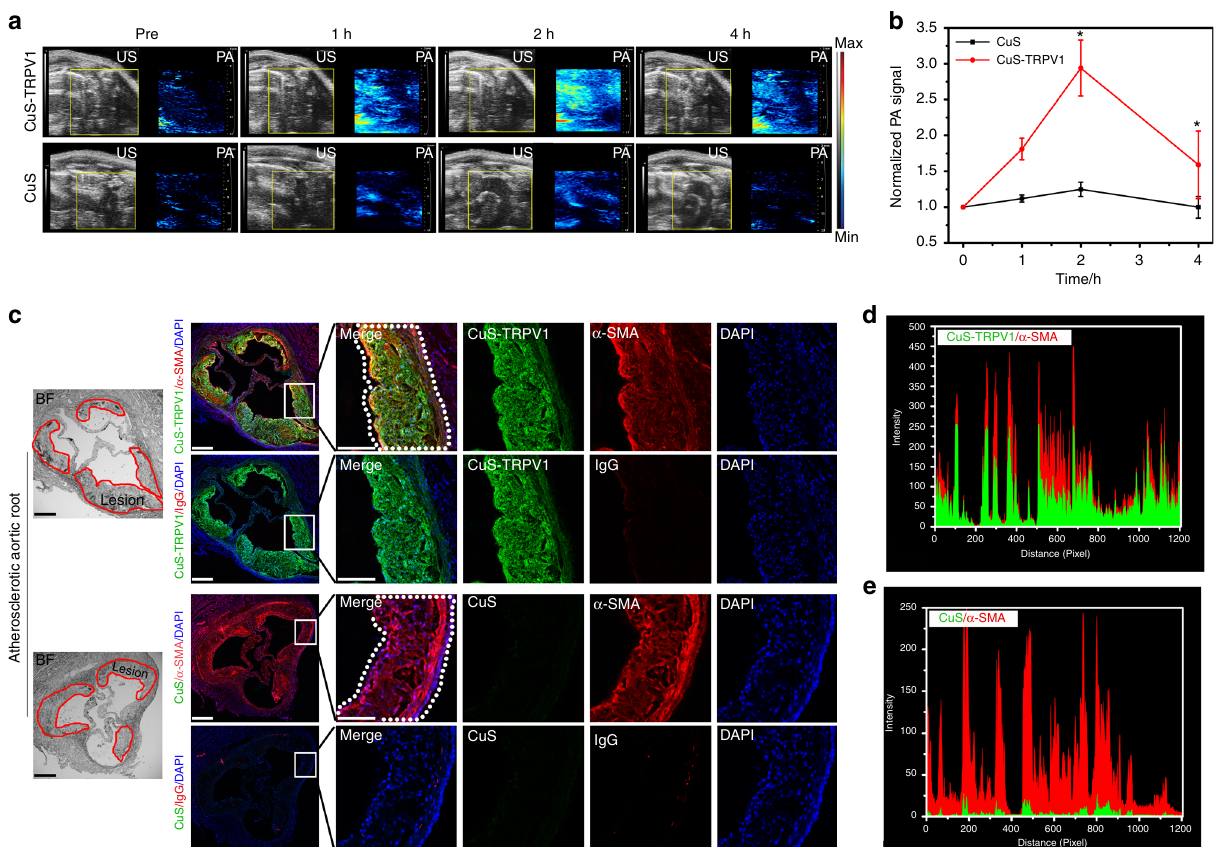
Fig. 5 Localization of CuS-TRPV1 in high-fat-fed ApoE − / − mice. a US and PA imaging of the aortic arch in ApoE − / − mice intravenously received CuS-TRPV1 (upper panel) and CuS (lower panel). Yellow squares were used to indicate aortic arch location. b PA intensity of the aortic arch at different time-points. Data are shown as mean ± S.D. ( n = 3), and analyzed by Student ’ s t -test. * P < 0.05 vs. pre. c Representative immuno fl uorescent micrographs of aortic roots sections demonstrating CuS-TRPV1 within atherosclerotic plaque at 2 h post-injection. From right, blue (DAPI), red (VSMC maker α -SMA or background control IgG), green ( fl uorescein-conjugated CuS-TRPV1 or CuS) and merge. The red line indicated the lesion border. The white square gave a view of the magni fi cation of a region of lesion as indicated on the right (Scale bar = 75 μ m, n = 3 mice per group). d and e Fluorescence intensity pro fi les of the regions enclosed by the white dotted